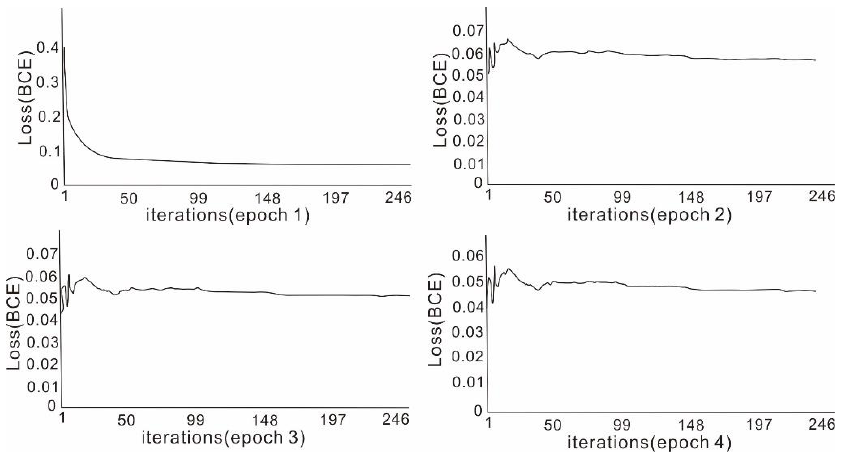
Figure 7. The change diagram of loss function curve during the training process. The binary-cross entropy function (BCE) is used as the loss function.